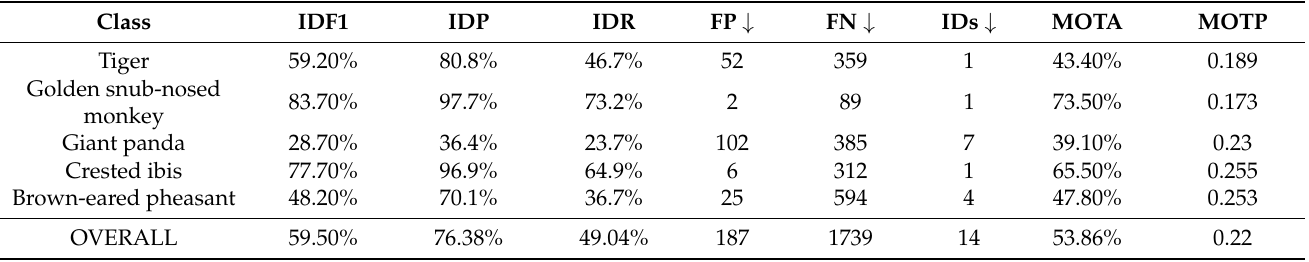
Table A1. Results of the same few-shot object detector in our model combined with BYTETrack tracker on the MOT-EA dataset.